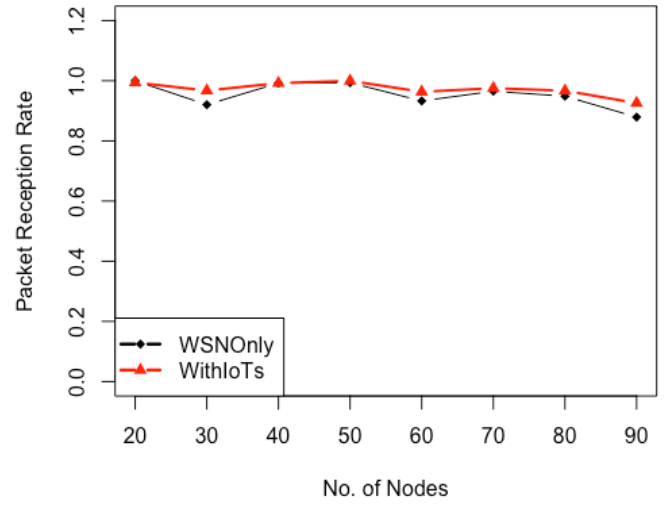
Figure 10. Improvement in Reception rate of WSN when IT Platform is